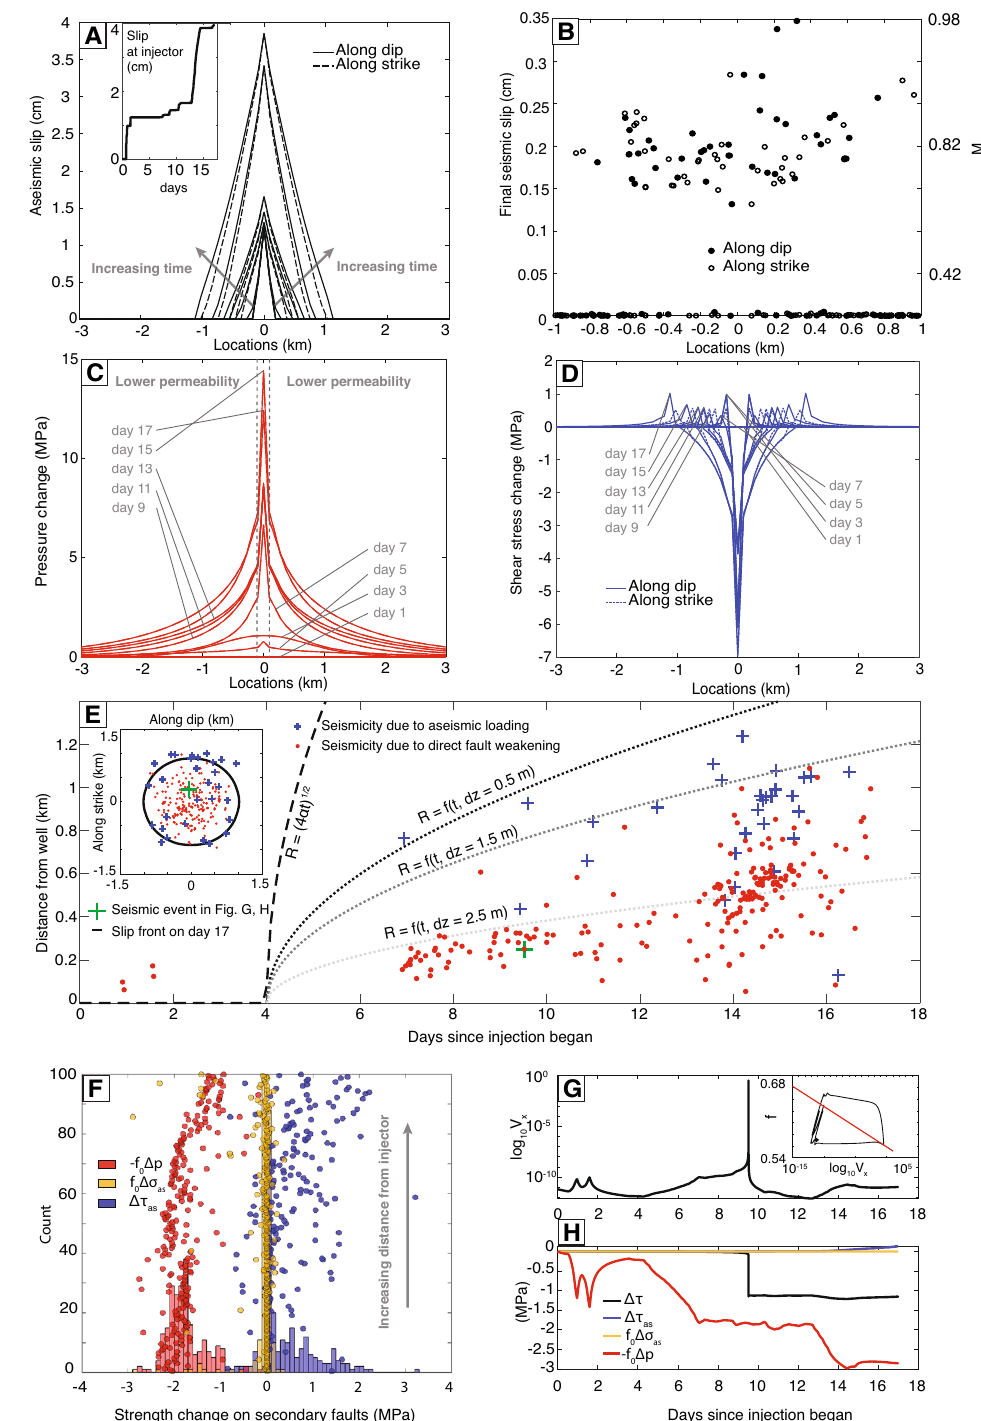
Figure 3. Time evolution of ( A ) aseismic slip on the main fault along dip and strike directions. Inset shows cumulative slip at the well. ( B ) Total seismic slip at the end of injection. ( C ) Pore pressure change in the fault zone. Vertical dashed gray lines mark the transition from the higher permeability near-well region to the lower permeability region. ( D ) Shear stress change on the main fault. Aseismic slip, pressure, and shear stress change are plotted every 2 days. ( E ) Space-time plot of the simulated seismicity and mechanisms that induced them. Inset shows map view of seismicity. Dashed line shows the diffusion length scale over time; dotted lines show the theoretical prediction of seismicity front triggered by pore pressure change (Methods). t : time, dz : vertical distance of secondary faults from the main fault. ( F ) Histogram showing contributions to fault strength change on secondary faults at the time of a f 0 (cid:31) p ; shear stress loading from aseismic slip, �τ as ; seismic event (slip velocity > 0.1 m/s): direct weakening from pressure increase, − normal stress loading from aseismic slip, f 0 �σ as . Dots show contributions of each mechanism as a function of cumulative counts of seismicity. ( G ) Secondary fault slip velocity evolution (at location marked in ( E )). Inset shows friction coefficient versus slip velocity. ( H ) Contribution of main fault aseismic slip and pore pressure diffusion to inducing seismic slip at the secondary fault location marked in ( E ). �τ : change in total shear